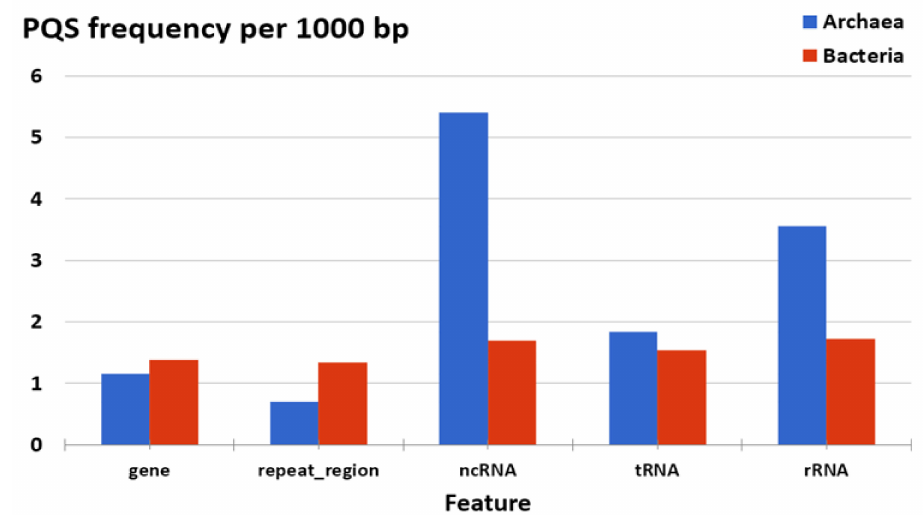
Figure 8. Di ff erences in PQS frequency by DNA locus. The chart shows PQS frequencies normalized per 1000 bp annotated locations from the NCBI database and shows a comparison between Archaea and Bacteria. Archaea G4-prone motifs are strongly over-represented in ncRNA and rRNA compared to the average G4 density in Archaea (mean f = 1.207), but also compared to bacteria. PQS count is provided in Supplementary Table S3 Excel